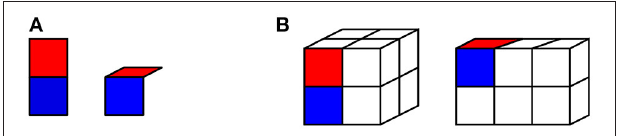
FIGURE 1 | Illustration of the hand used in our model. (A) Our hand model, in “straight” position (left) and “bent” position (right). The “palm” is shown in blue; the articulated “finger” in red. (B) The objects navigated by the hand in our experiments: a 2 2 2 cube (left), and a 3 2 1 cuboid (right). The hand × × × × is shown in its “straight” position on the cube, and in its “bent” position on the